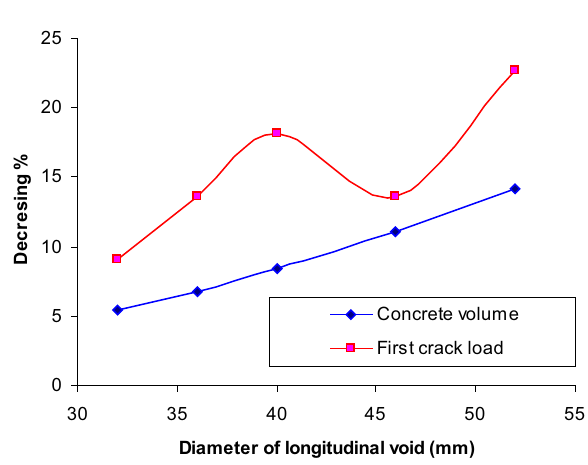
Fig. 7 Decreasing in cracking load and concrete volume with differ- ent longitudinal voids